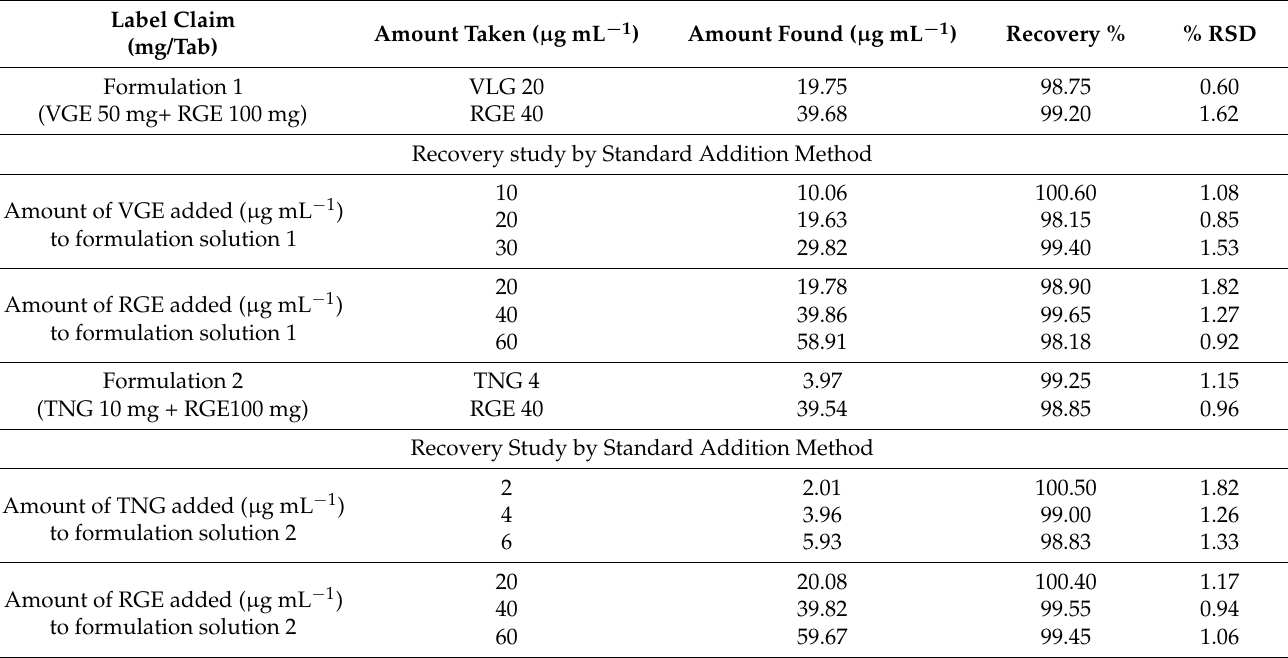
Table 6. Analysis results of drugs from formulations and standard addition method by optimized HPLC